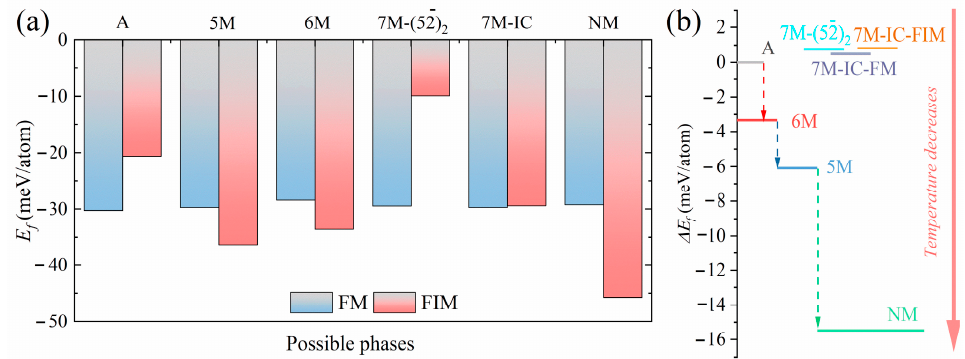
Figure 2. ( a ) Formation energy of each of the possible phases in FM and FIM states, ( b ) formation energy difference between each possible martensitic phase and austenite of Ni 2 Mn 1.5 In 0.5 alloy. The formation energy difference between austenite and different martensites is also calculated based on the determination of each phase’s magnetic ground state; the results are shown in Figure 2b. The formation energies of the two models of the 7M martensite are almost equal, with a difference of only 0.06 meV/atom between the 7M (52) − and 2 7M–IC in the FM state. This means that the difference in phase stability between these two phases is not significant. It is probable that the macroscopic stress field during the mar- tensitic transformation determines which model of the 7M modulated structure is pre- sented in the experiments. This may be one of the reasons for the controversy between the two models in the experiments. Notice that the reasons for contradictory experimental